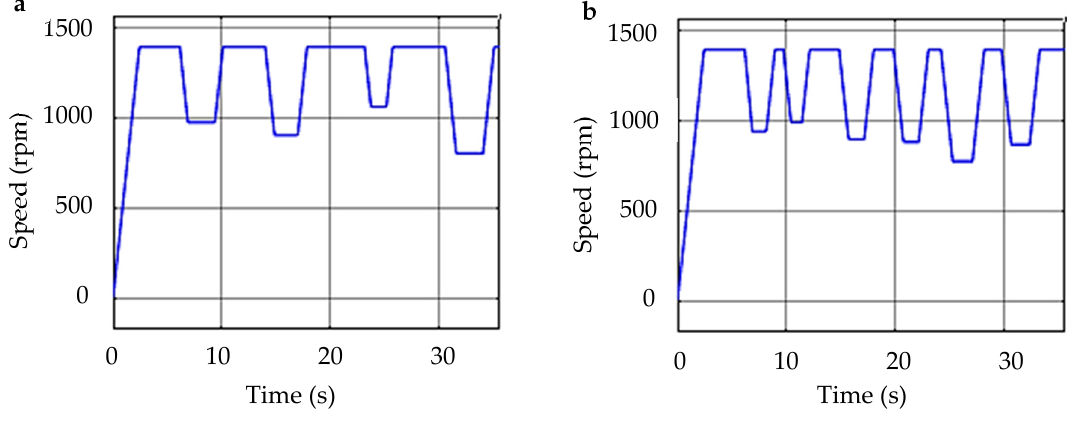
Figure 10. IM speed profiles. Figure 10. IM speed